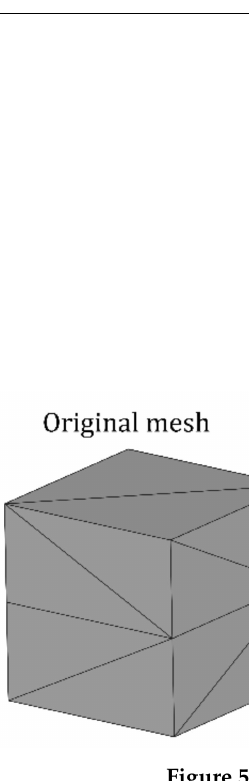
Figure 5. Insertion of zero-thickness interface elements into the finite element